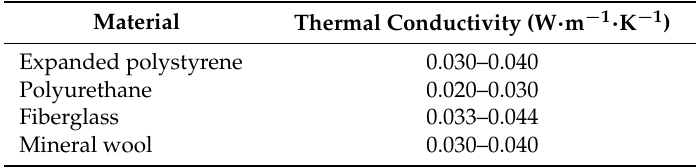
Table 1. Thermal conductivity of selected building insulation materials